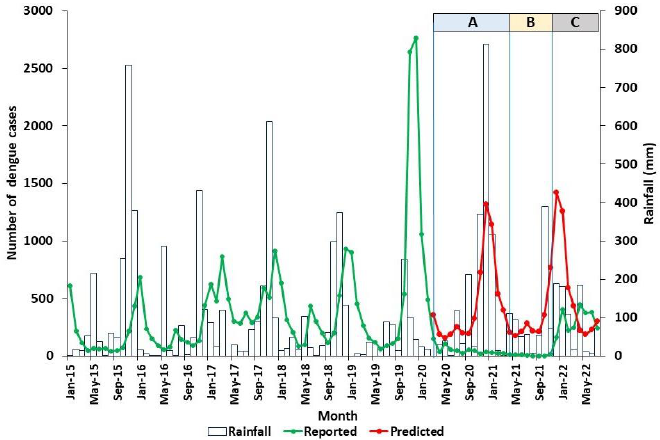
Figure 3. Predicted and actual numbers of dengue cases in relation to rainfall in the Jaffna district. Colour coding for periods A, B, and C is the same as in Table 1.